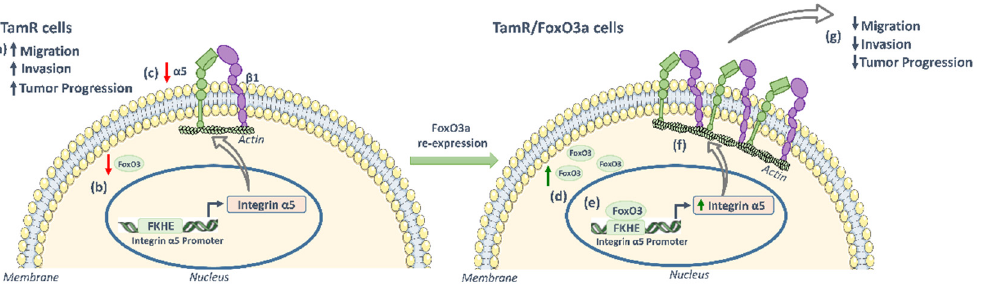
Figure 6. FoxO3a inhibits TamR cells progression by inducing integrin α 5 expression . Compared to tamoxifen responsive MCF-7, TamR cells (a) show higher tumor progression-associated features and express reduced levels of both (b) FoxO3a and (c) integrin α 5. FoxO3a re-expression (d) transactivates the human integrin α 5 promoter by binding to an FHRE core sequence , (e) inducing α 5 expression (f), with consequent inhibition of tumor progression (g).